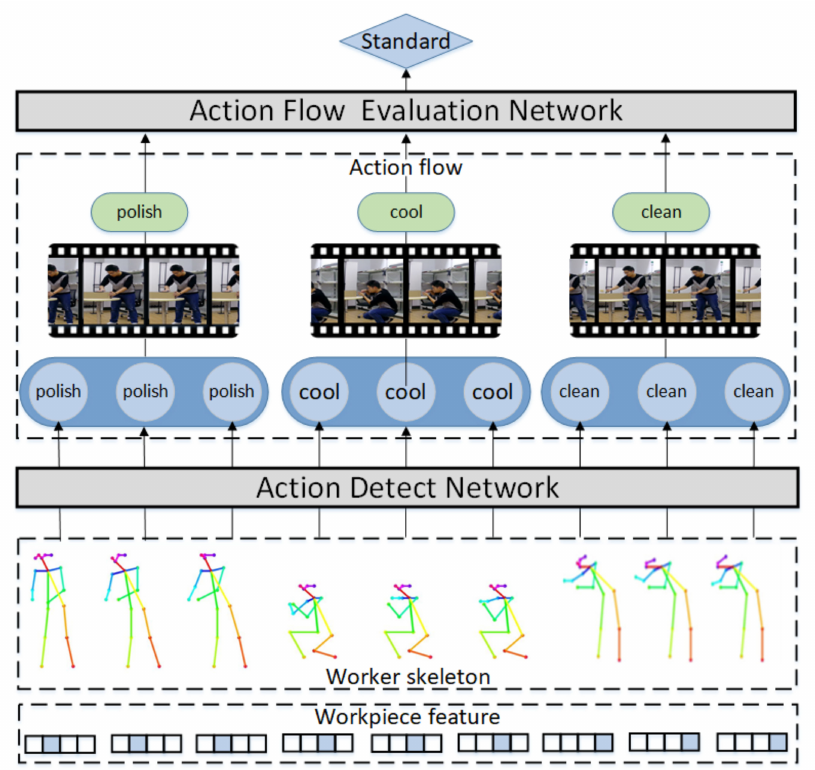
Figure 1. The overall framework of our method. An action detect network is used to acquire segmented actions and insert them into the process evaluation network for standardized